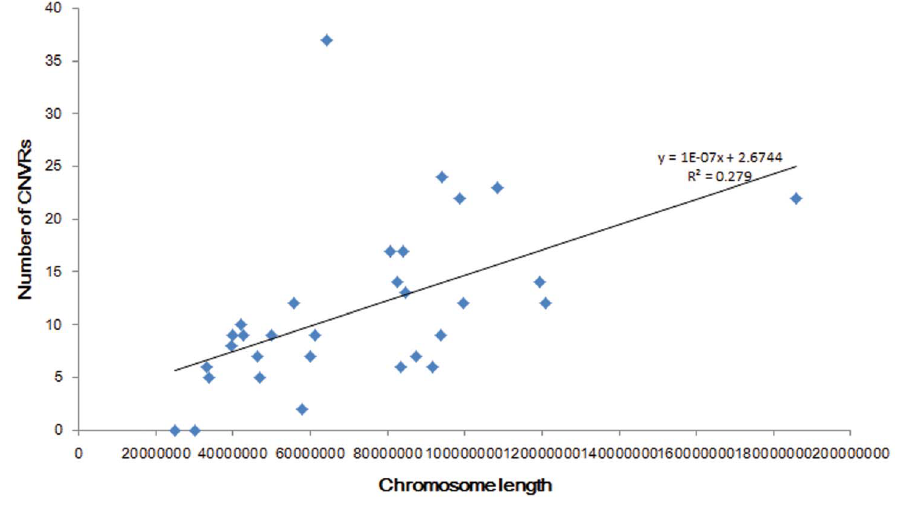
Figure 4. Correlation between the number of CNVRs and chromosome length.